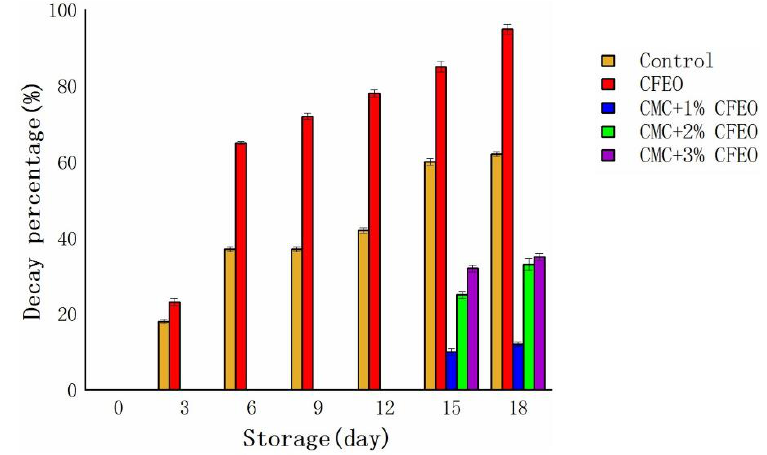
Figure 10. The effect of different treatment groups on decay percentage of Shine Muscat grapes.